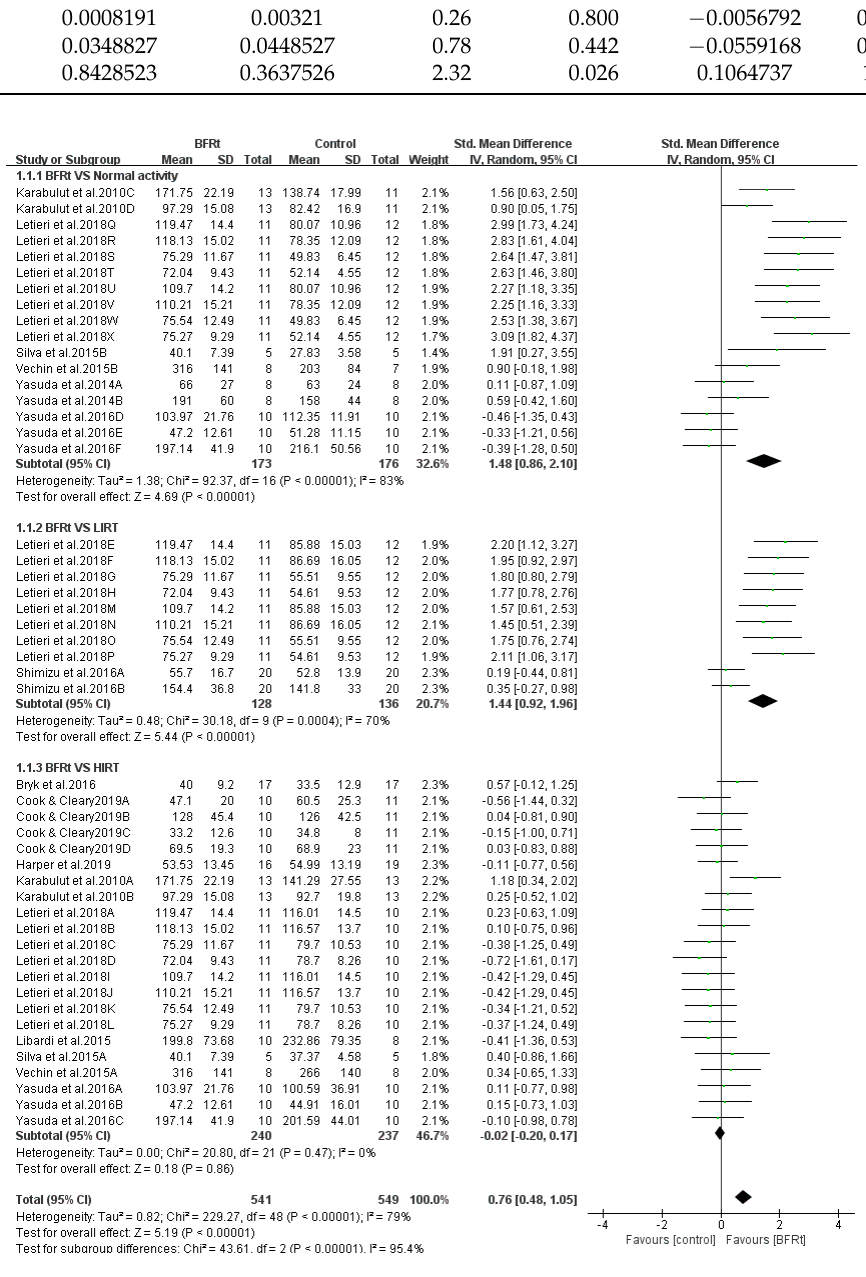
Figure 5. Subgroup analysis of the effect of BFRt intervention on lower-limb muscle strength. Different letters for the same study represent different muscle strength assessment methods [19,22,29–37].